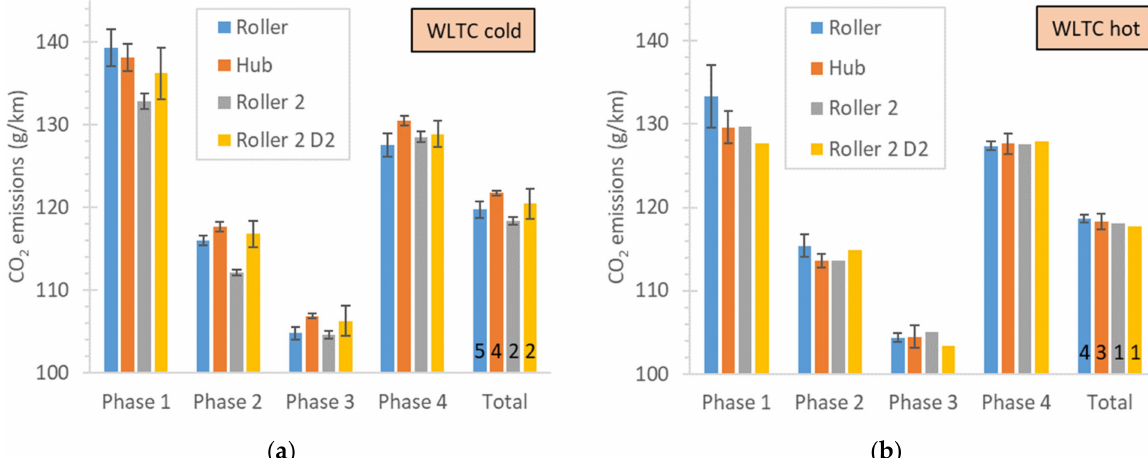
Figure 6. CO 2 emissions: ( a ) cold-start WLTC; ( b ) hot-start WLTC. Error bars show one standard deviation of the number of repetitions shown in the bars. The results of the roller- and hub-type dynamometers are compared with a second roller-type dynamometer (Roller 2) with the same driver and a second driver